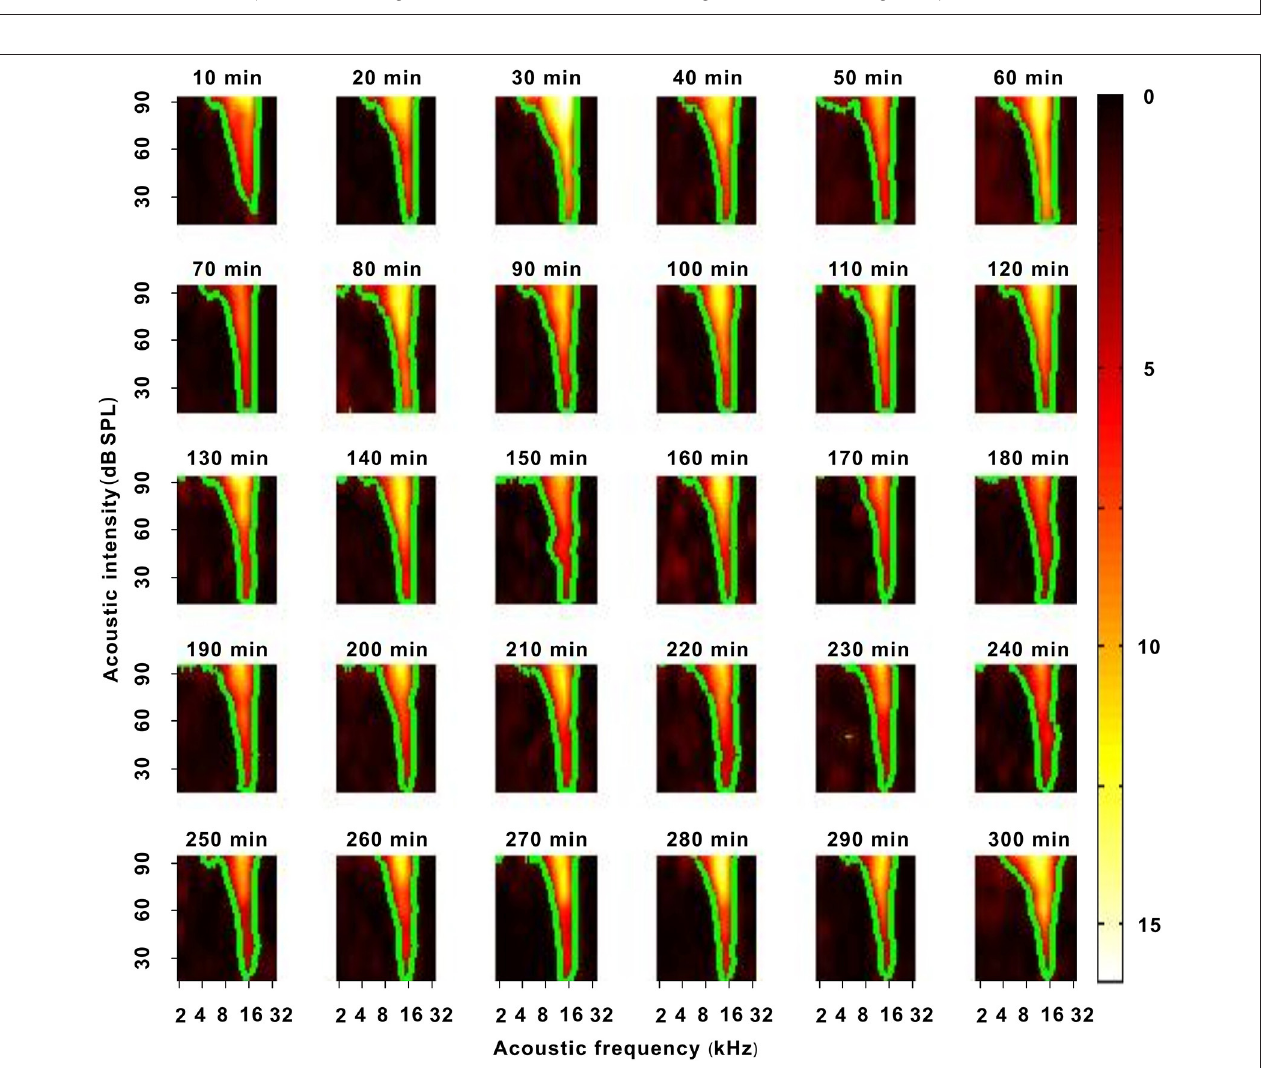
FIGURE 9 | Oct., t = − 0.776, P = 0.453; ES 60 dB SPL : (4.962 ± 3.122) vs. (7.708 ± 3.883) spikes/Sti., t = − 4.960, P = 3.309 × 10 − 4 ; BW 60 dB SPL : (1.177 ± 0.468) vs. (1.254 ± 0.479) Oct., t = − 2.132, P = 0.054]. The first recording session of each curve was the first recording session after urethane injection (i.e., the recording session at 10min in each neuron). The last recording session of each curve was the recording session with the strongest response.